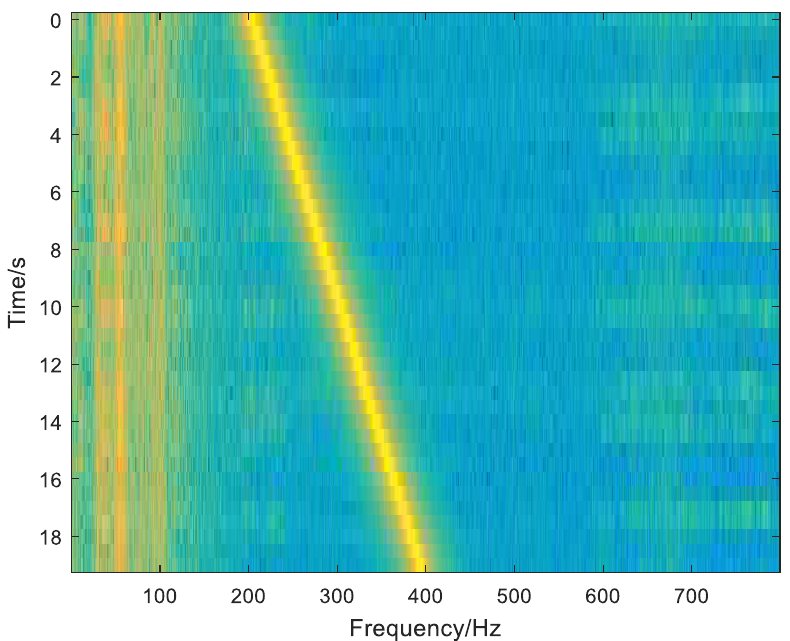
Figure 13. LOFAR diagram of the receiving data.